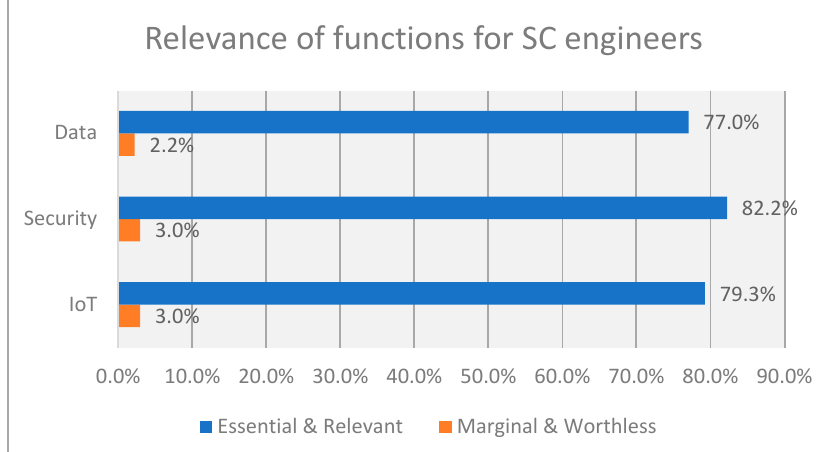
Figure 2. Summary of relevance of functions for SC engineers.